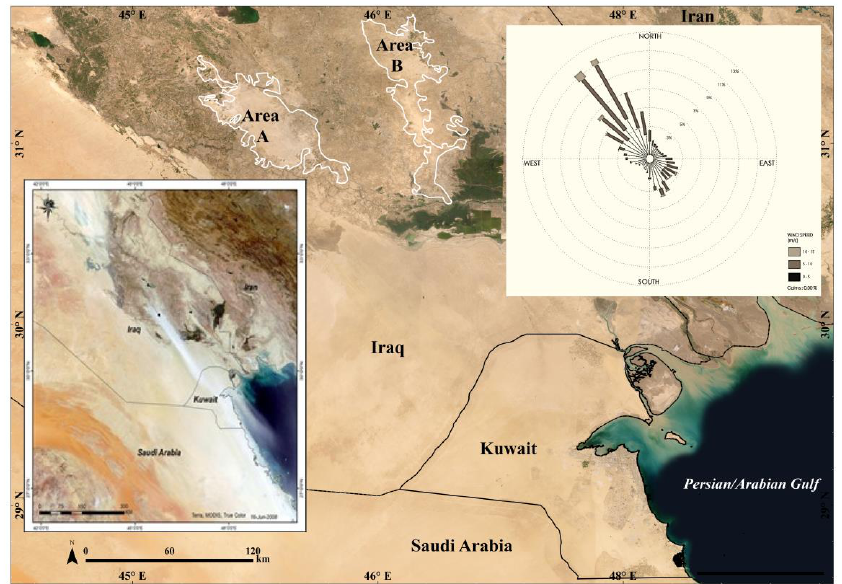
Figure 1. Recent two MODIS images showing the two sand and dust storms hotspots with wind rose from Kuwait City (2000 – 2020).